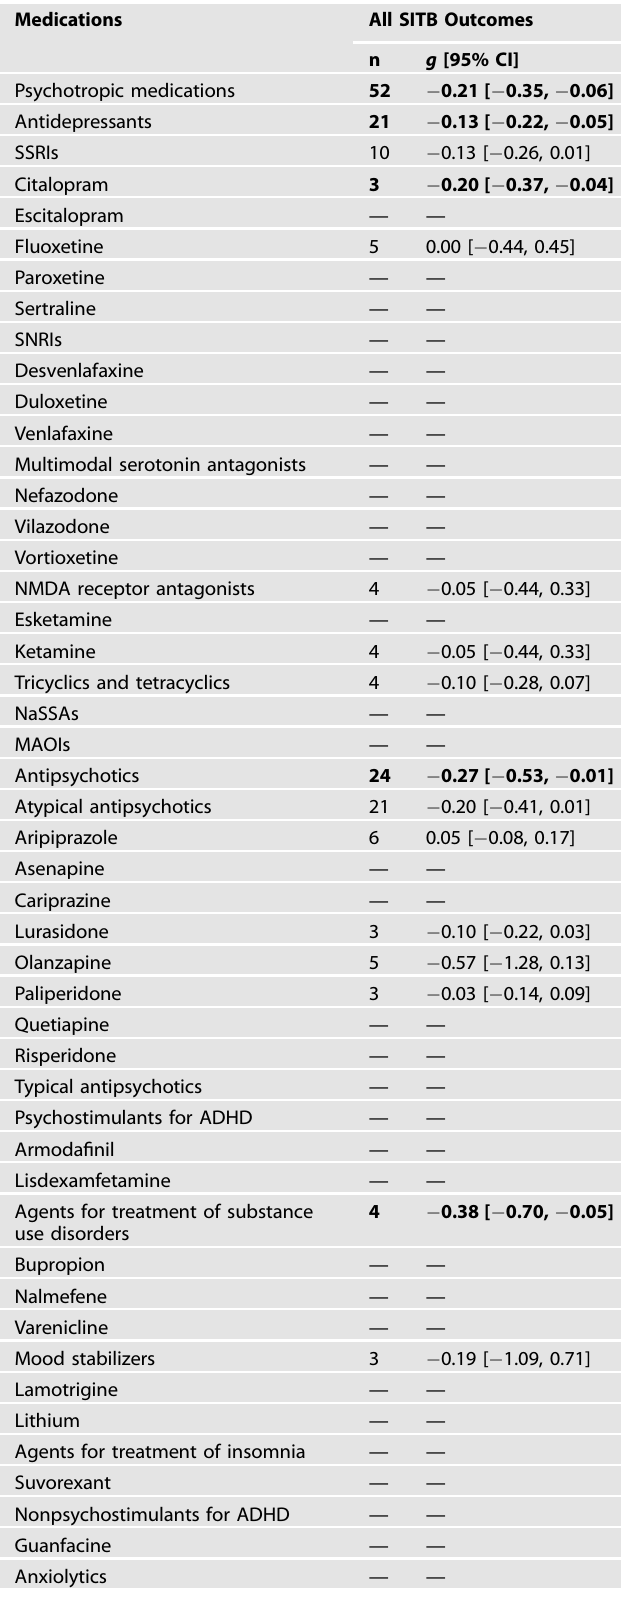
Table 3. Pairwise meta-analyses for aggregated continuous